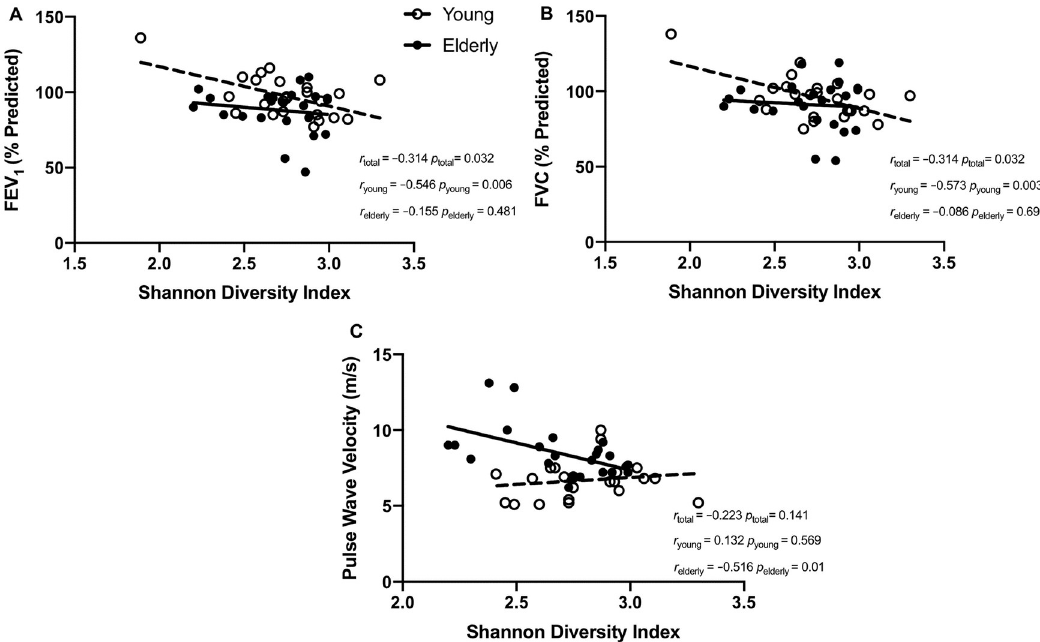
Fig 3. Physiological correlates of microbiome alpha-diversity in young and elderly subjects. Sub-group correlations between the Shannon diversity index of the lung microbiome and lung function parameters (A) FEV 1 (% Predicted), (B) FVC (% Predicted) as well the arterial stiffness parameter (C) pulse wave velocity. Young and elderly groups are indicated by unfilled and filled circles respectively. The line of best fit is indicated with a broken line for the young population and with a continuous line for the elderly. Correlation coefficients and associated p values are indicated for the total population ( r total ), the young sub-group ( r young ) and the elderly sub-group ( r elderly